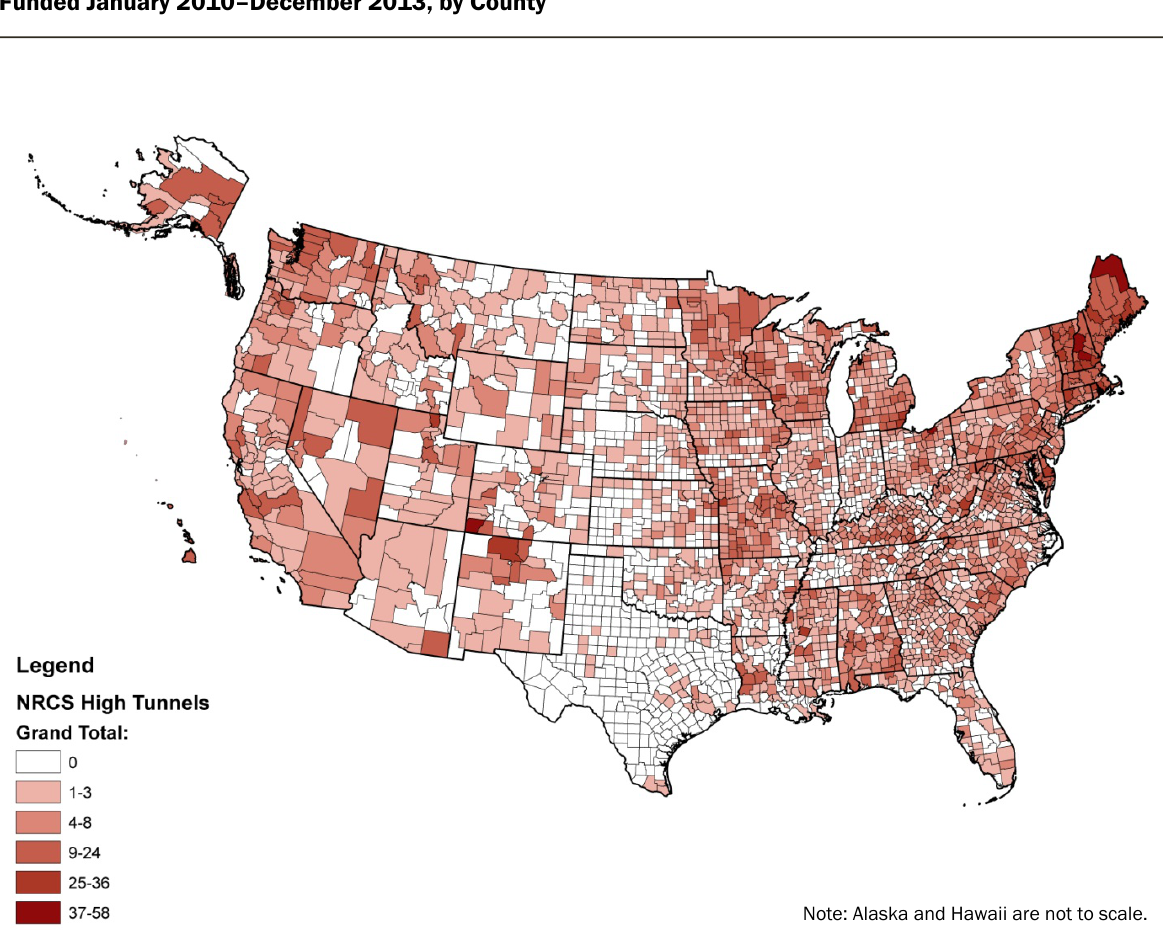
Figure 1. Number of USDA Natural Resources Conservation Service (NRCS) High Tunnels in the